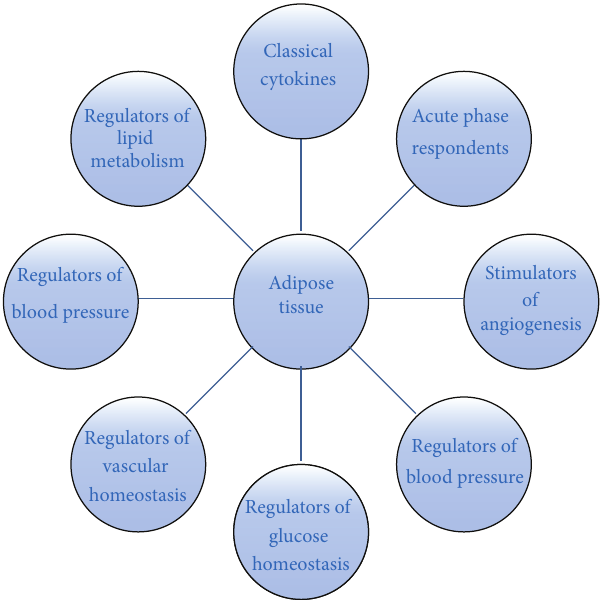
Figure 1: Overview of the various physiological functions of adi- pokines expressed and secreted from adipose tissue